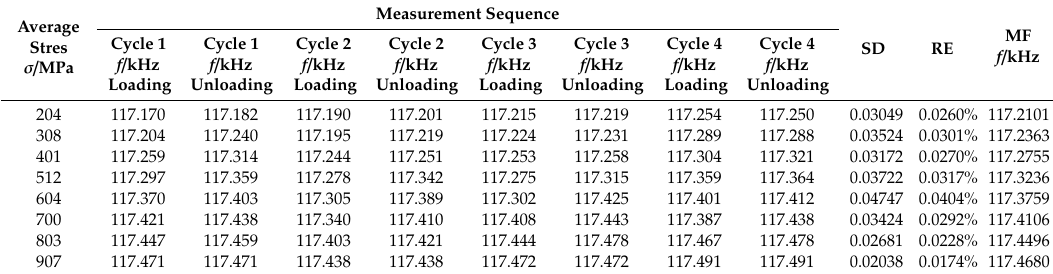
Table 5. The experimental date—15